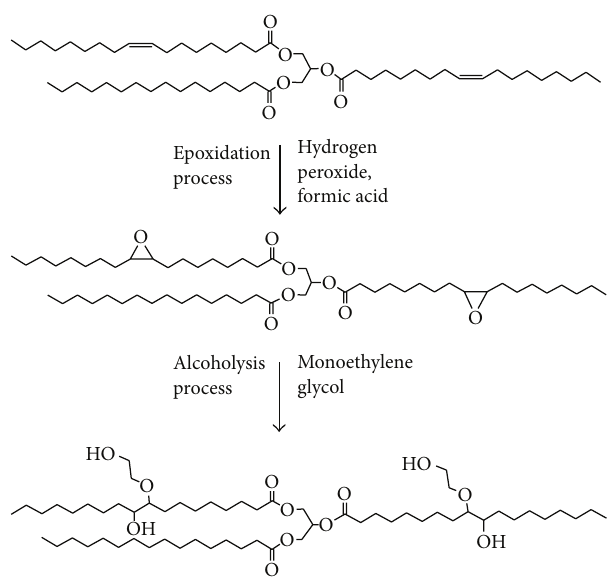
Figure 1: Schematic diagram for the synthesis of polyol from palm olein.